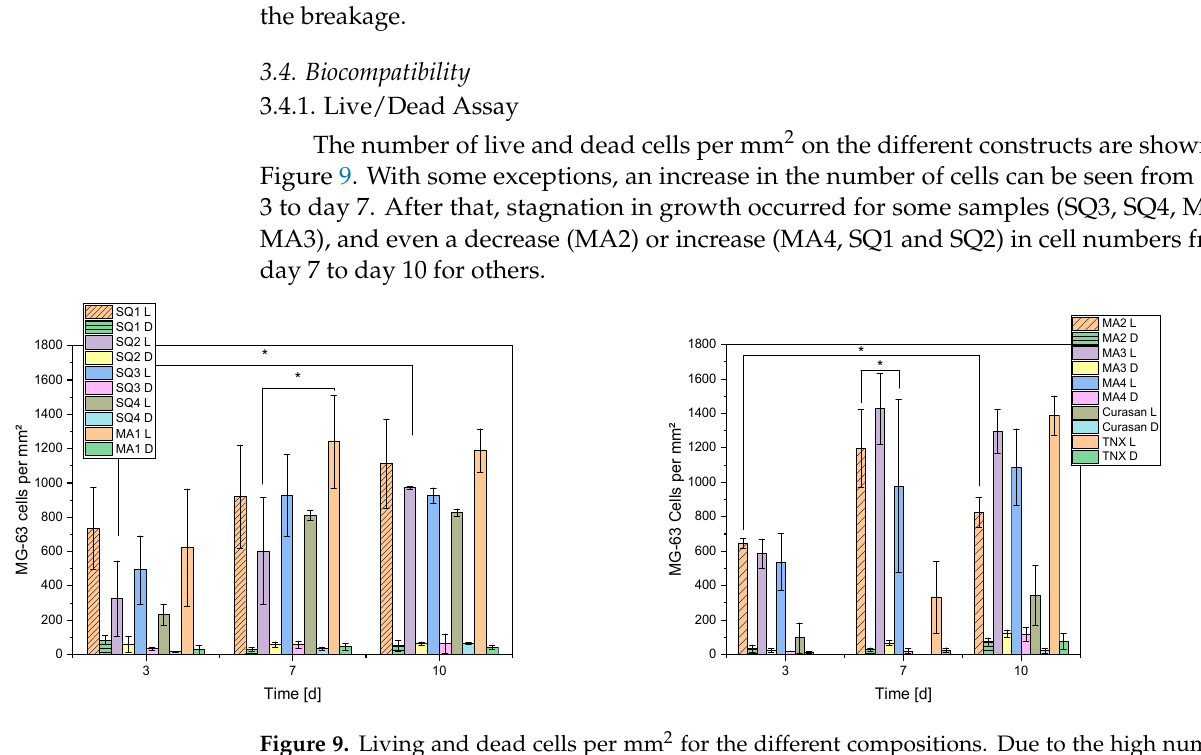
Figure 8. Relative volume and total porosity for PMMA ( left ) and PMSQ ( right ) samples.